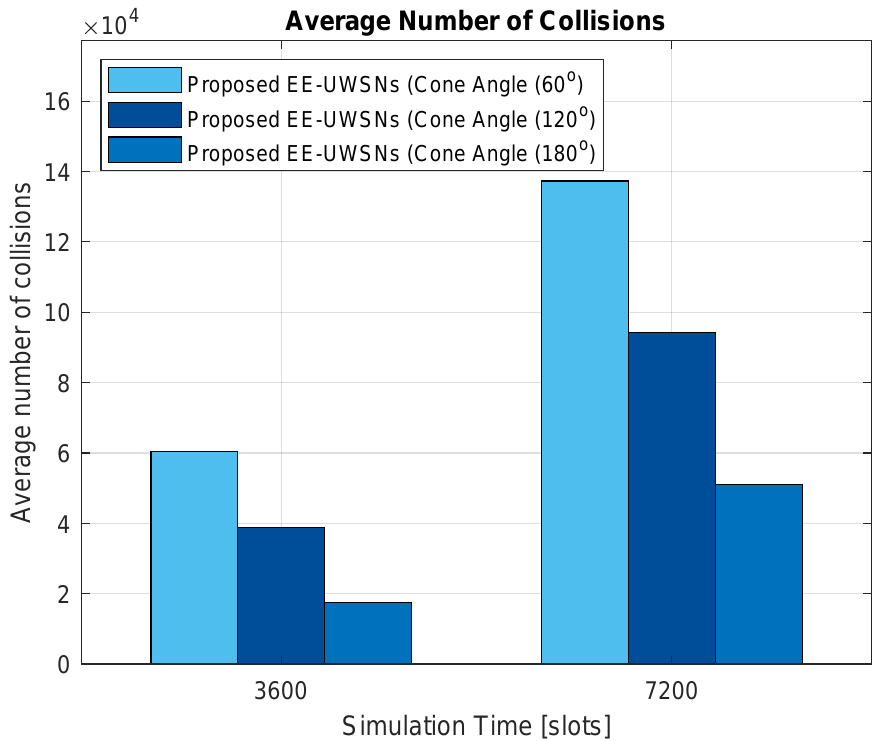
Figure 13. The effect of changing cone angle on number of